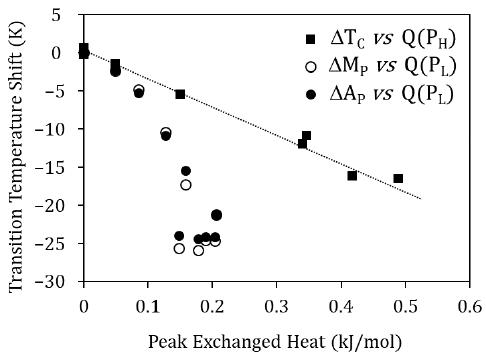
Figure 8. Curie temperature drop ∆ T C due to quench from T WQ vs. heat released in the P H peak, and MT temperatures drop ( ∆ M P and ∆ A P ) vs. heat released at peak P L .